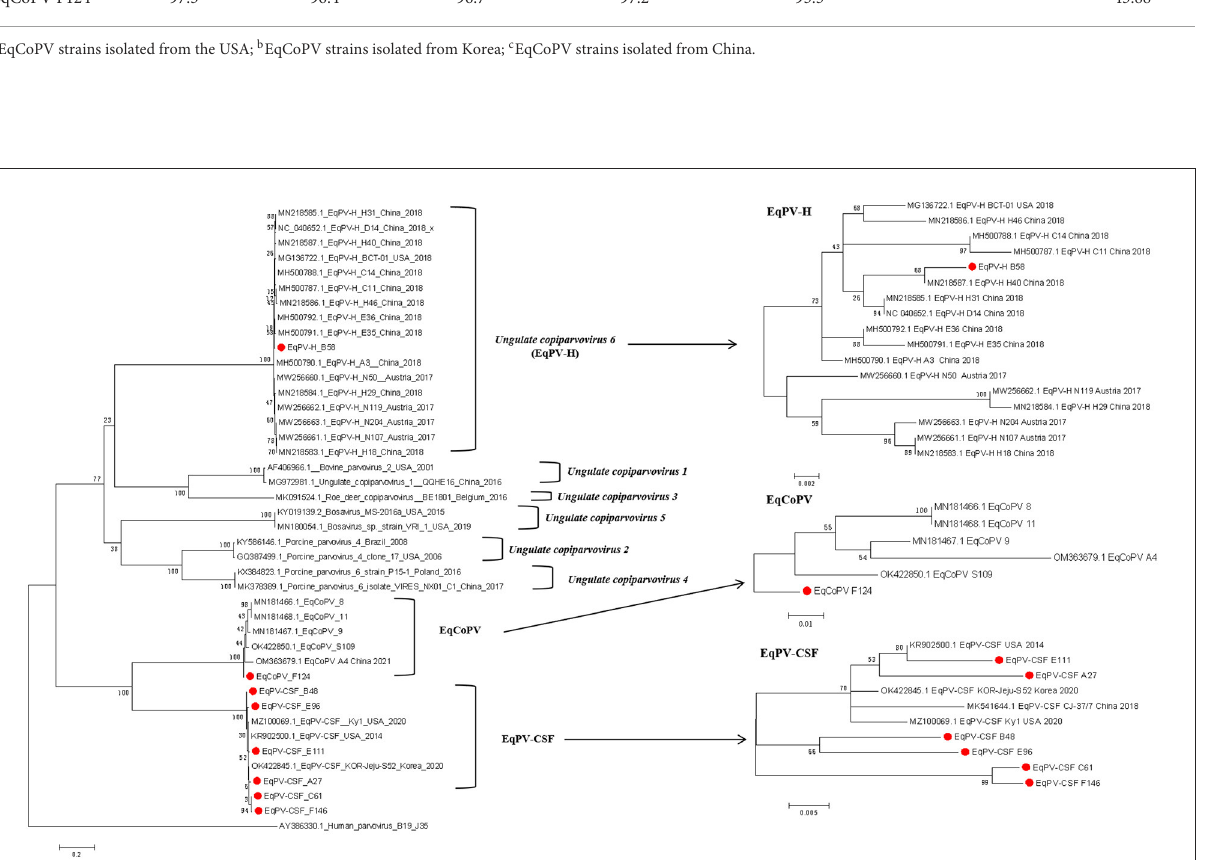
The nucleotide (upper right)/amino acid (bottom left) identity of the NS1-coding sequence EqCoPV 8 a